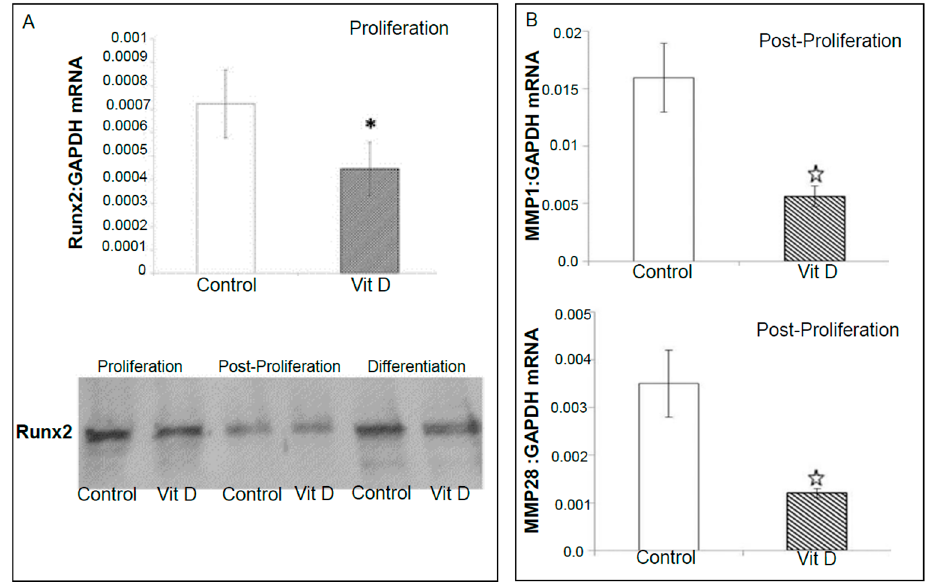
Int. J. Mol. Sci. 2017 , 18 , 642